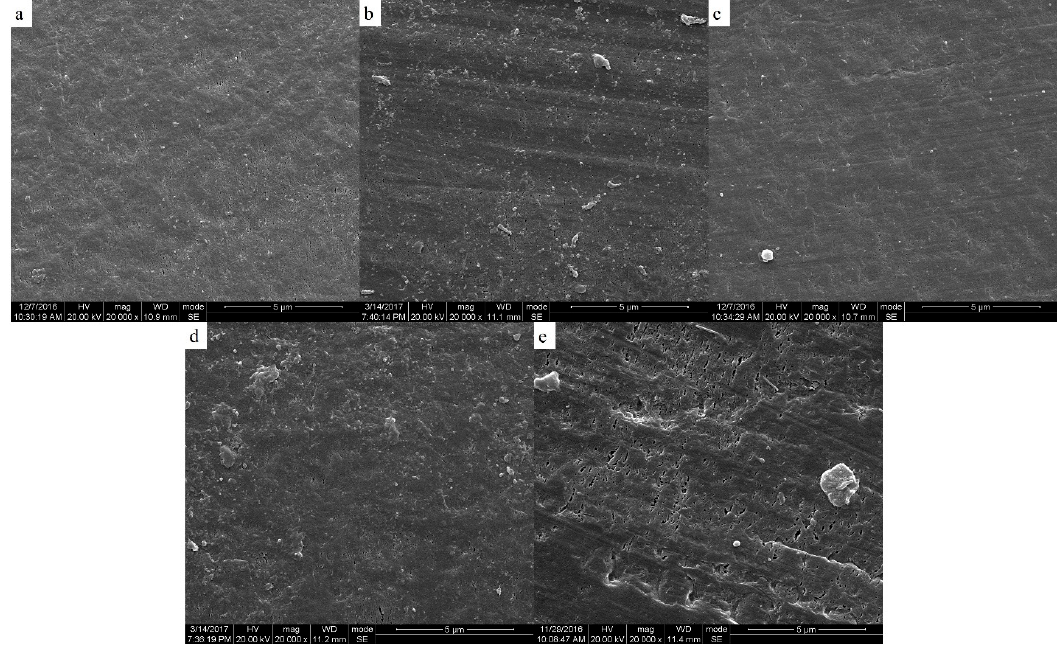
Figure 8. Scanning electron micrographs of the outer surface of membrane; samples wer cold Figure8. Scanningelectronmicrographsoftheoutersurfaceofmembrane; sampleswercoldcrystallized crystallized at ( a ) 240 °C; ( b ) 250 °C; ( c ) 260 °C; ( d ) 270 °C; ( e ) 280 °C . at ( a ) 240 ◦ C; ( b ) 250 ◦ C; ( c ) 260 ◦ C; ( d ) 270 ◦ C; ( e ) 280 ◦